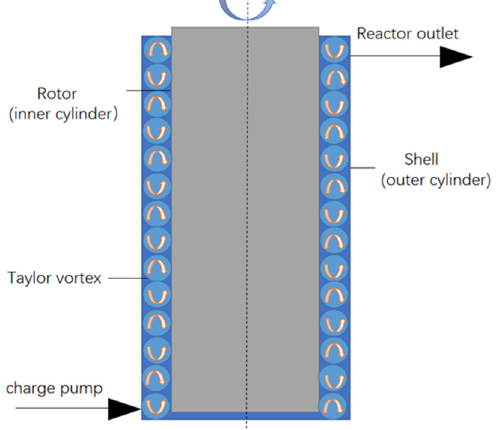
Figure 1. Schematic diagram of conventional Teller reactor.